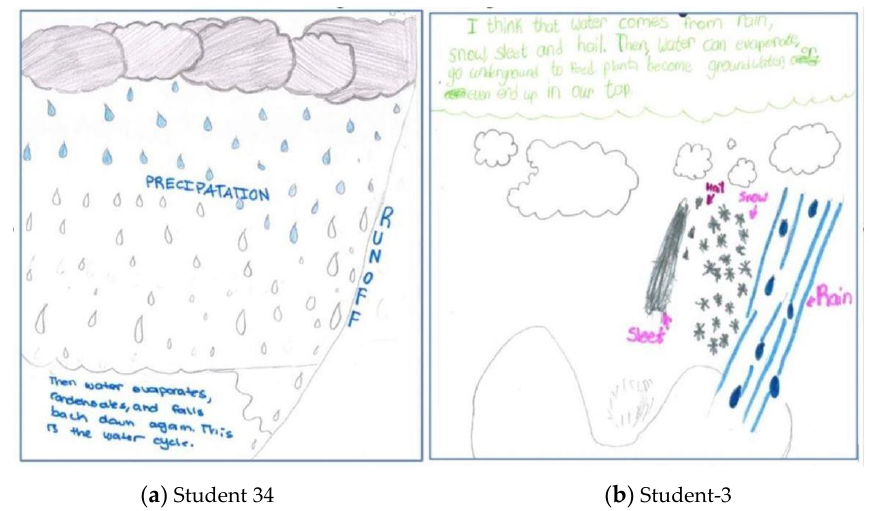
Figure 3. Pre-Drawings Assessments from two different study participants, one in class #1 ( a ) and the other in class #2 ( b ) that highlight only surface and atmospheric interactions.